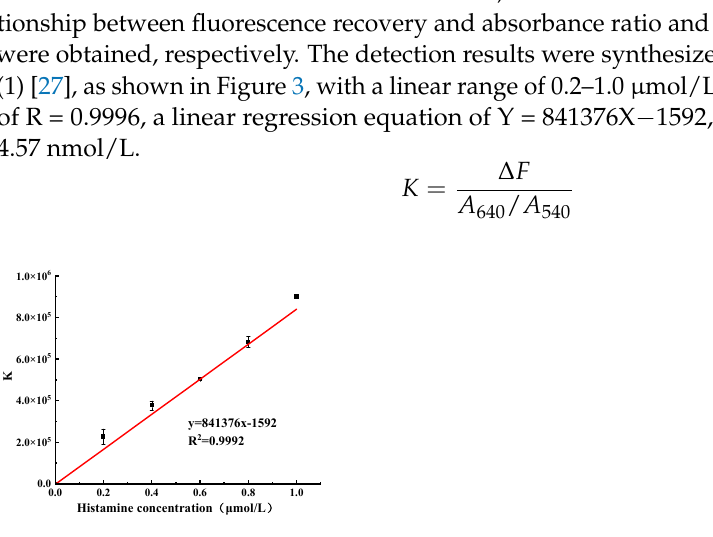
∆𝐹 𝐾 = 𝐴 (cid:2874)(cid:2872)(cid:2868) /𝐴 (cid:2873)(cid:2872)(cid:2868)